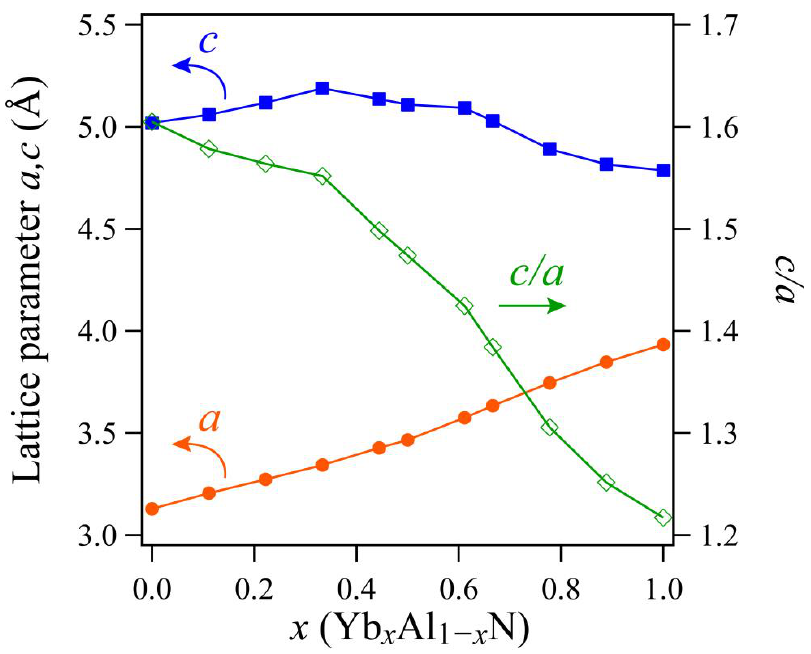
Figure 3. Calculated lattice parameters of Yb x Al 1−x N. Orange and blue traces represent the changes to lattice parameters, a and c , respectively, and the green line denotes the ratio of lattice parameters, c/a .